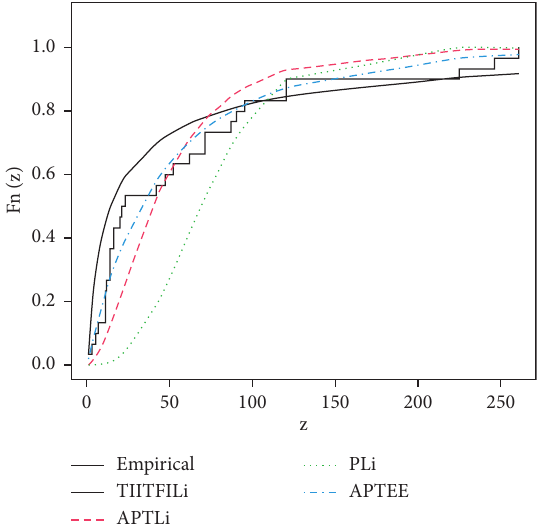
Figure 4: Estimated cdf of the TIITFILi and other competing models for the